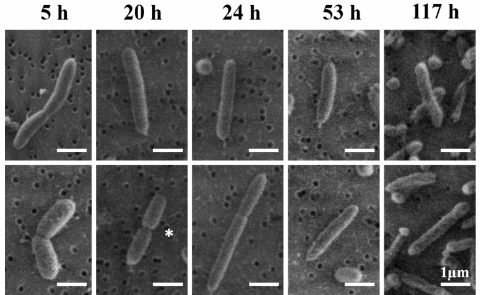
Figure 2. Scanning electron microscopy (SEM) images illustrating the cell division pattern throughout the life cycle of a V. fischeri population. The depicted timepoints correspond to the lag (5 h), exponen- tial (20 h and 24 h), stationary (53 h), and death (117 h) phases (see Figure 1A). The full-grown adult cells of ca. 2 µ m length are observed at 53 h. Cells undergoing division are commonly observed only in the first two phases (5 h, 20 h, and 24 h); * clear example of a septum in the exponential phase (20 h). Dark round features in the background are ca. 0.2 µ m pores in the supporting polycarbonate